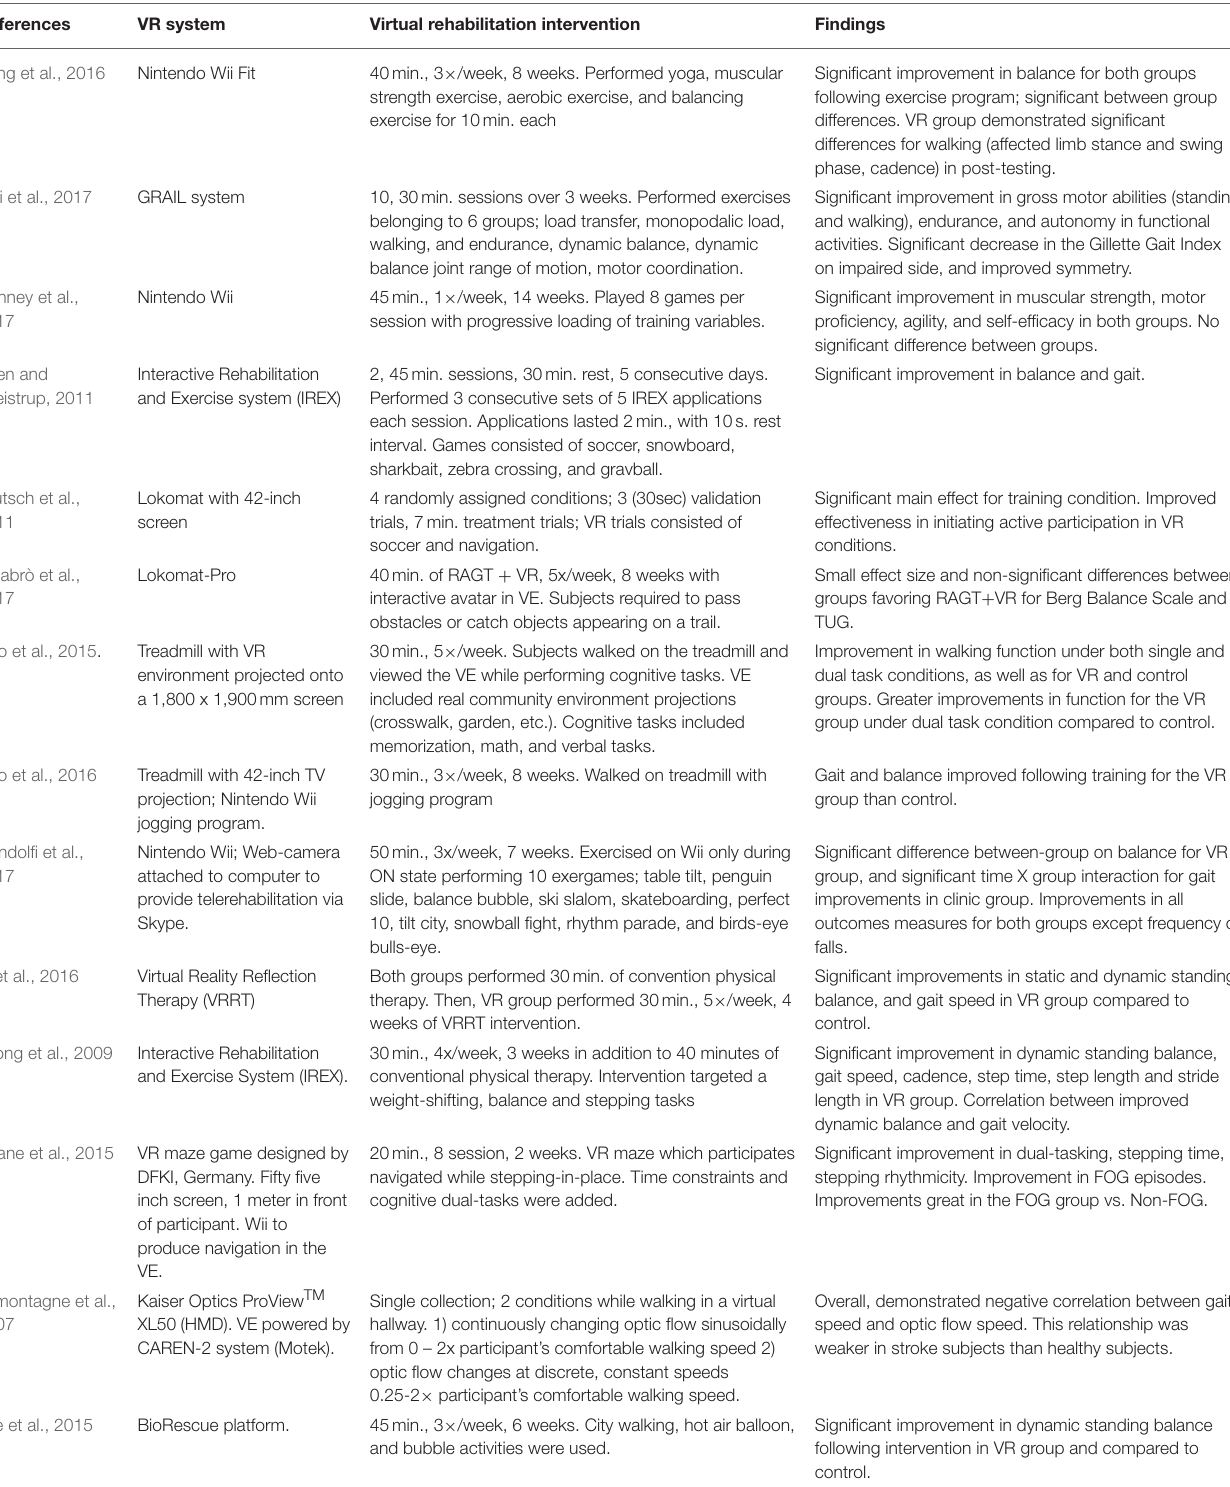
TABLE 2 | Summary of virtual reality interventions and findings of the included articles investigating virtual reality interventions on motor performance in neurologic